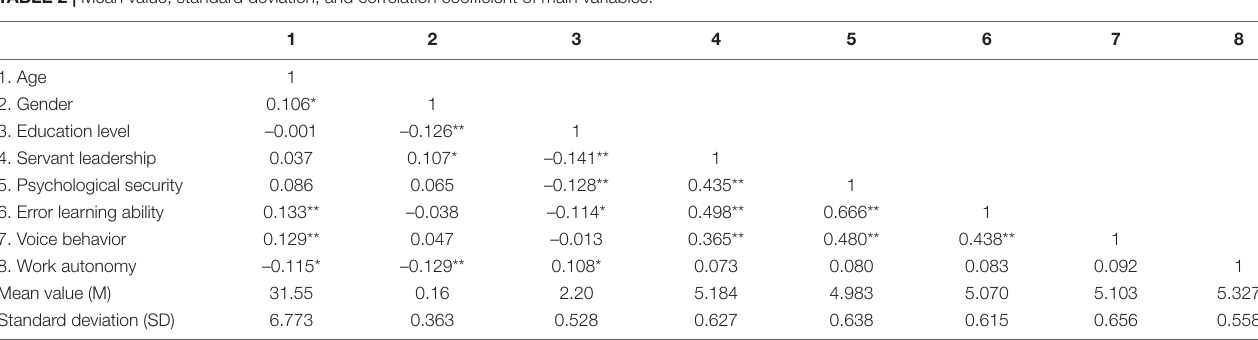
TABLE 2 | Mean value, standard deviation, and correlation coefficient of main variables.